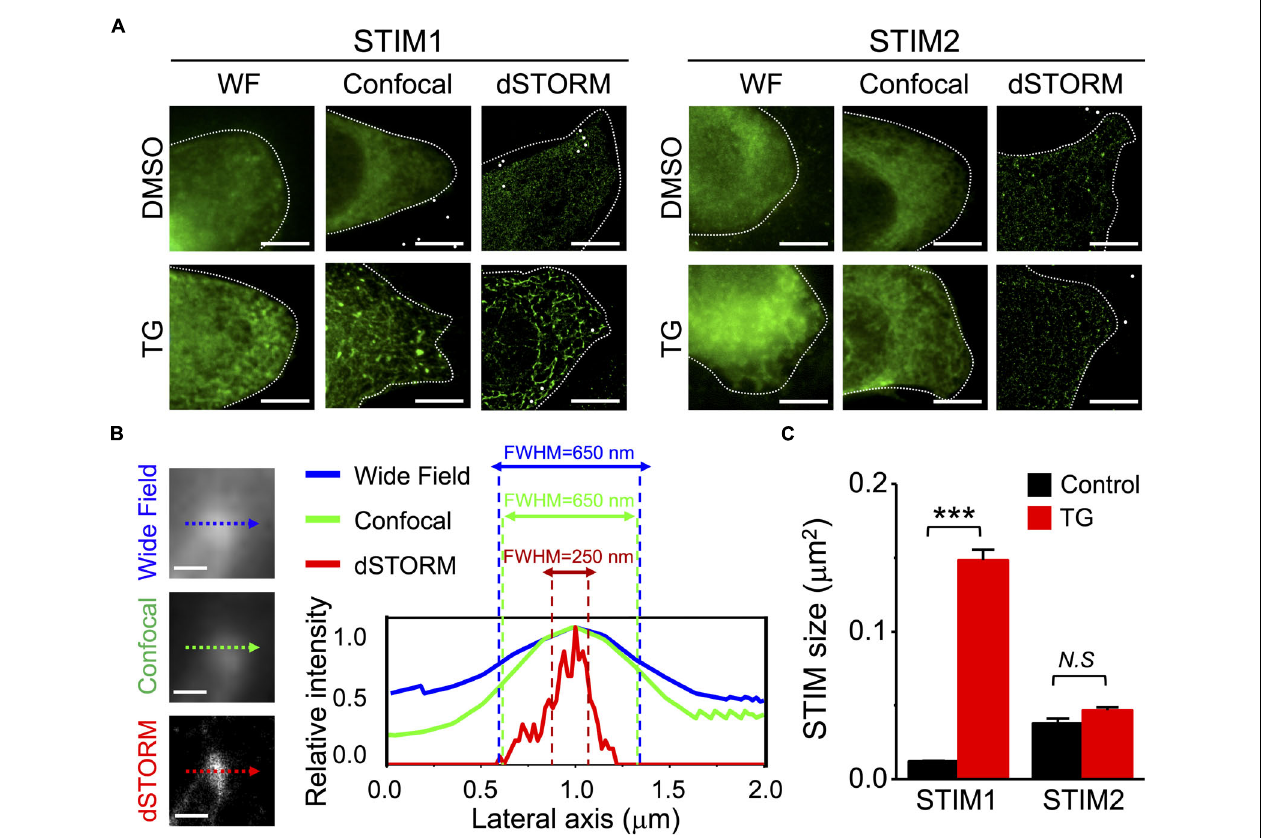
FIGURE 1 | Visualization of the nanoscale architecture of STIM proteins in SiHa cervical cells overexpressing EGFP-STIM1 by confocal microscopy and dSTORM imaging. (A) STIM proteins (green) with or without thapsigargin (TG) stimulation (2 µ M, 10 min) were imaged using wild-field (WF) epifluorescent, confocal microscopy, and super resolution direct stochastic optical reconstruction microscopy (dSTORM). Scale bar, 10 µ m. Representative images are from at least six different cells of three different experiments. (B) SiHa cervical cells overexpressing EGFP-STIM1 were fixed for immunostaining for STIM1 after treatment with TG for 10 min. (Left), images of the same area in WF epifluorescent, confocal microscopy, and dSTORM. (Right), fluorescent intensity profiles along the dotted lines. We used full width at half maximum (FWHM) to measure the fluorescent intensities of STIM1 imaged by different methodologies. Scale bar, 0.2 µ m. (C) Quantitative analyses of STIM molecular size using Integrated Morphometry Analysis (IMA) Measurement Parameters with MetaMorph Software ( Supplementary Figure 3 ). Column, mean ± SEM from at least six cells of three independent experiments. *** P < 0.001, compared with one-way ANOVA with a Dunnett’s post hoc test. N.S.,